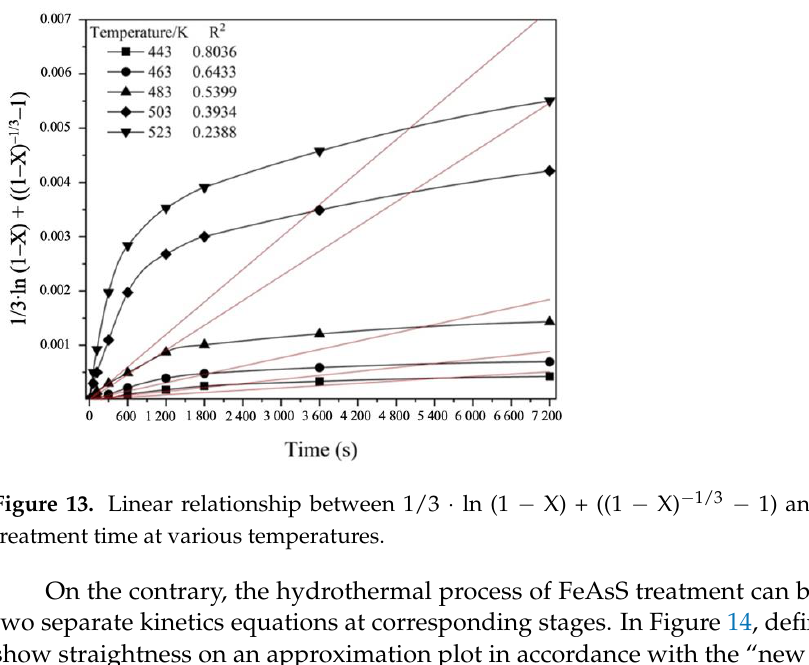
Figure 13. Linear relationship between 1/3·ln (1 − X) + ((1 − X) − 1/3 − 1) and hydrothermal treatment time at various temperatures.